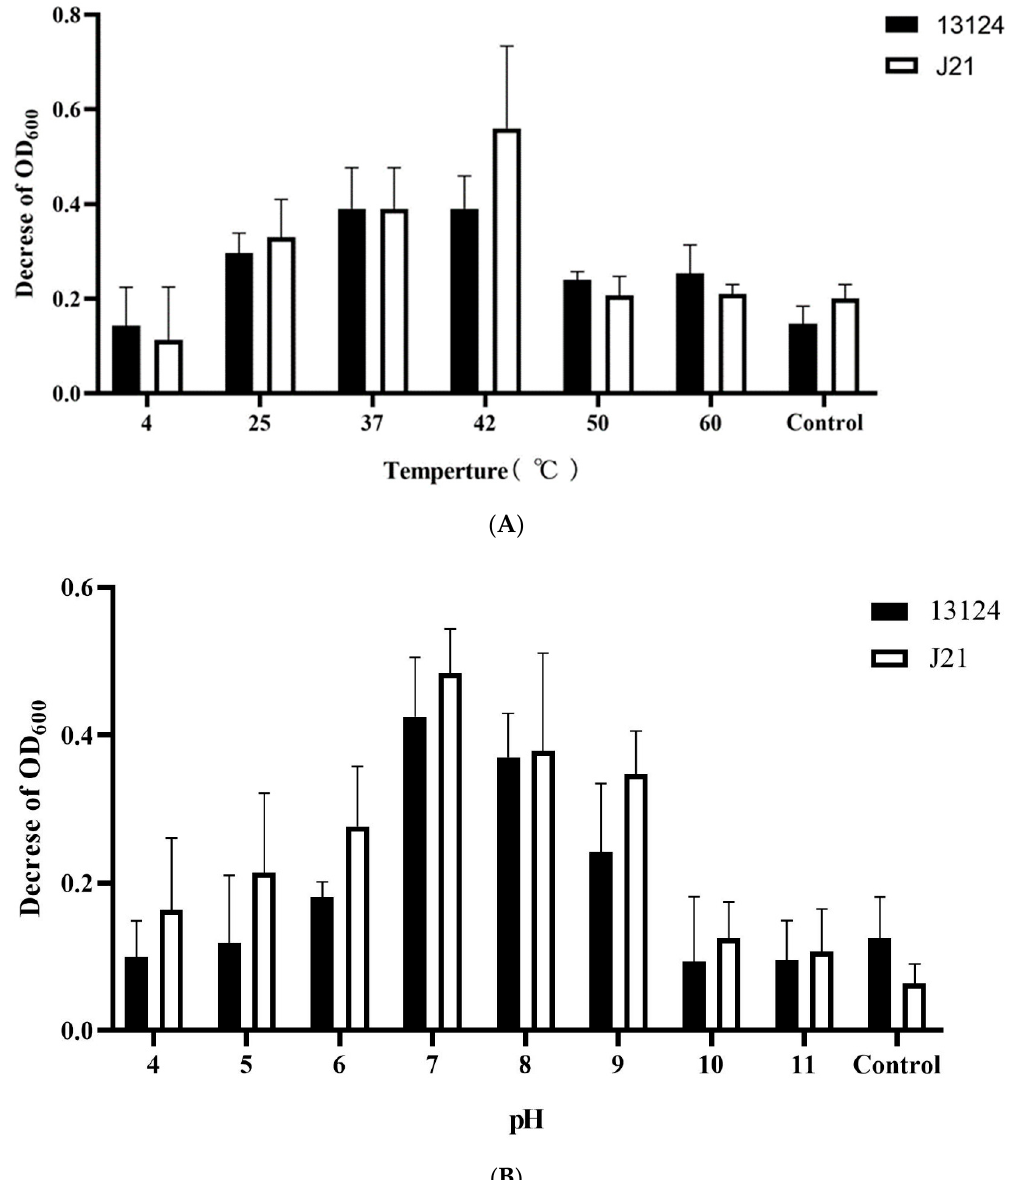
Figure 3. Lytic activity of endolysin LysCP28 in stress conditions. ( A ) The tolerance to temperature was measured after previous incubation for 2 h in a range of temperatures. The graph represents the difference between initial and final optical density of cultures treated with temperature-treated endolysin. ( B ) The activity in different pH levels was determined by analyzing the incubation of LysCP28 and cells over 2 h. The graph represents the difference between the initial and final optical densities of cultures treated with endolysin at different pH levels. OD 600 = 0.2 (ATCC 13124, J21 = 2 × 10 2 CFU/mL), OD 600 = 0.4 (ATCC 13124 = 5 × 10 4 CFU/mL, J21 = 1 × 10 5 CFU/mL), OD 600 = 0.6 (ATCC 13124, J21 = 2 × 10 7 CFU/mL), and OD 600 = 0.8 (ATCC 13124 = 4 × 10 7 CFU/mL, J21 = 6 × 10 7 CFU/mL).